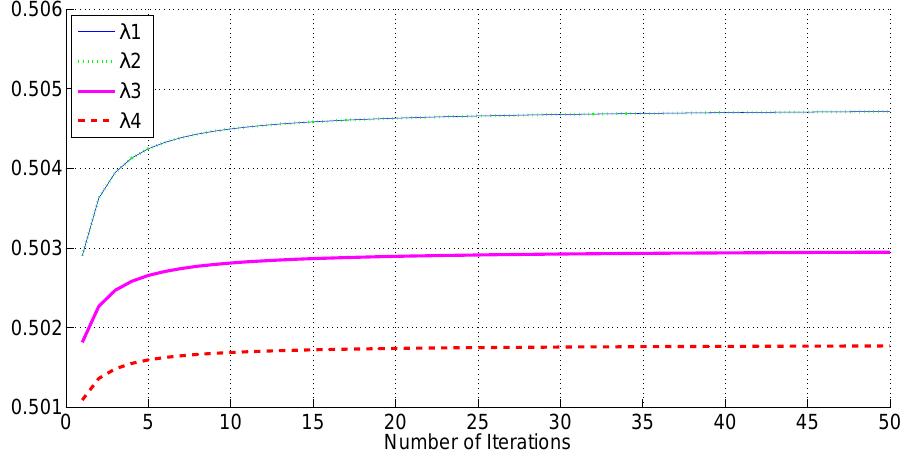
Figure 5. Convergence of Dual